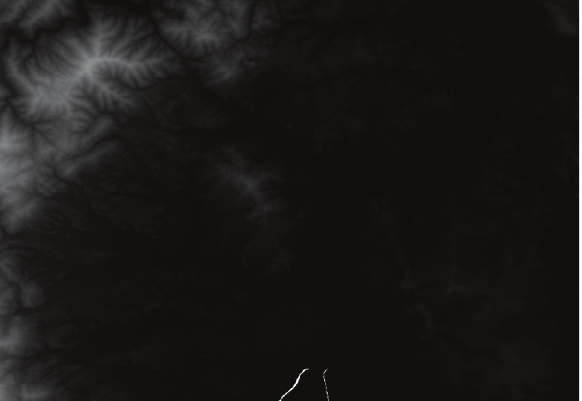
Figure 5. MLIT 5mDEM